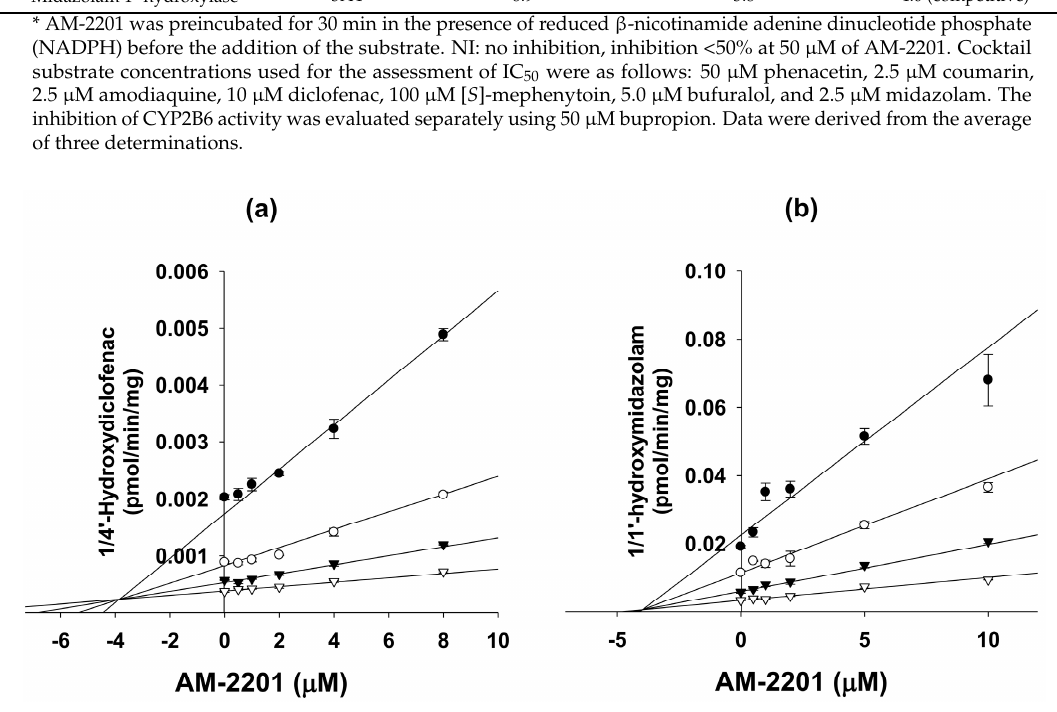
Figure 2. Representative Dixon plots for the inhibitory effect of AM-2201 on ( a ) CYP2C9-catalyzed diclofenac 4 ′ -hydroxylation and ( b ) CYP3A4-catalyzed midazolam 1 ′ -hydroxylation activities in ultrapool human liver microsomes. Each symbol represents a substrate concentration: ( a ) diclofenac: , 2 μ M; , 5 μ M; , 10 μ M; , 20 μ M and ( b ) midazolam: , 1 μ M; , 2 μ M; , 4 μ M; , 8 μ M. Data represent the mean ± standard deviation (SD) ( n = 3).